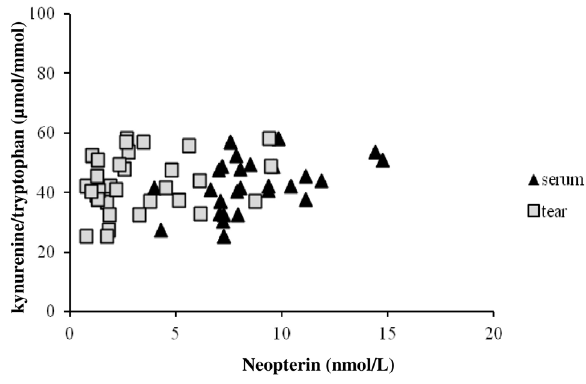
Table 2: Correlation between the parameters in study groups.